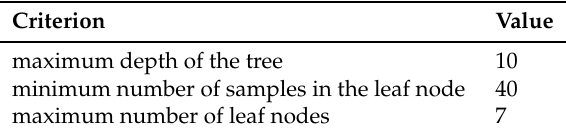
Table 5. Optimal values of CART-E tree construction.